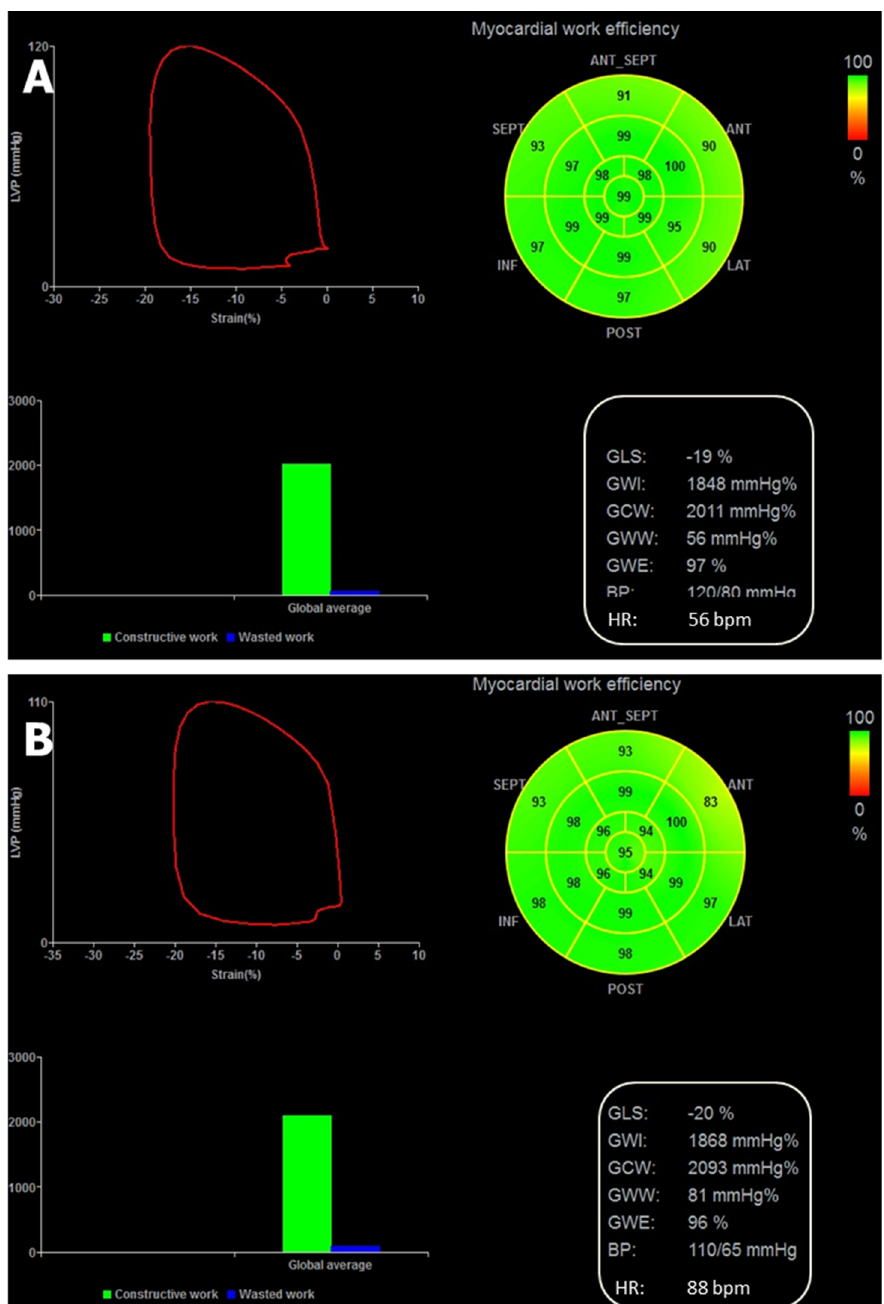
Figure 2. The strain-derived MW analysis of two healthy subjects with similar age, the first with sinus bradycardia and the second one with HR = 88 bpm: GWW is substantially higher in the subjects with faster HR. Strain-Pressure (LVP) loop (upper left panel of each figure), regional myocardial efficiency bull’s eye (upper right panel), diagram of average constructive and wasted work percentages (lower left panel) and list of global work components (lower right panel) in a 57-year-old healthy female subject with sinus bradycardia (HR = 56 bpm) ( A ) and in a 58-year-old healthy male subject with HR = 88 bpm ( B ). In presence of marginal changes of the global constructive work, the percentage of global wasted work is relatively low in the patient with sinus bradycardia ( A ) whereas it appears to be substantially increased in the patient with HR = 88 bpm ( B ). GCW = Global constructive work, GWE = Global work efficiency, GWW = Global wasted work, GWI = Global work